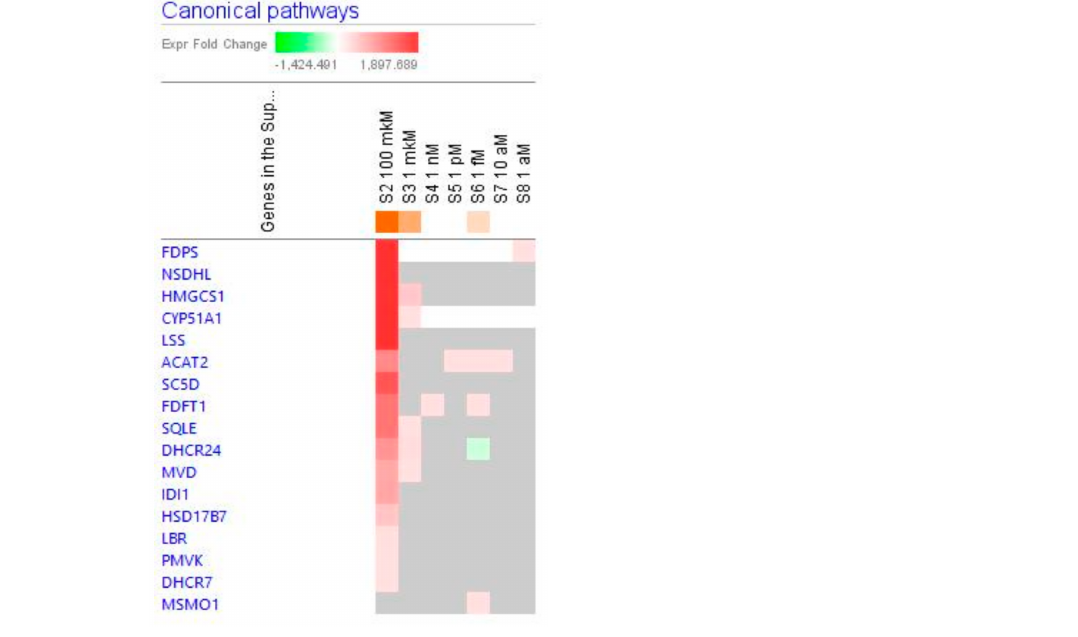
Figure 16. Effect of Rg5 on cholesterol biosynthesis metabolic pathway: Heatmap of gene expression (in fold changes compared to control, red, upregulation and green, downregulation), after exposure with ginsenoside Rg5 at different concentrations; the 100 µ M signature is shown in the leftmost column as solid red or green squares indicating genes that are upregulated or downregulated, respectively; color intensity indicates the actual log-fold